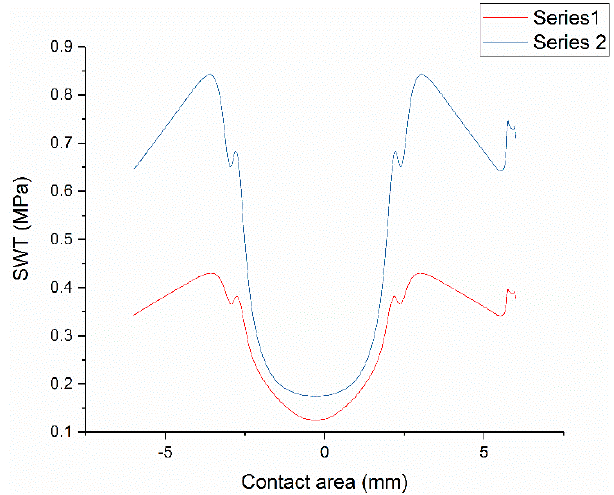
Figure 13. Smith–Watson–Topper (SWT) parameter distribution in contact area. Table 5. Finite element results.